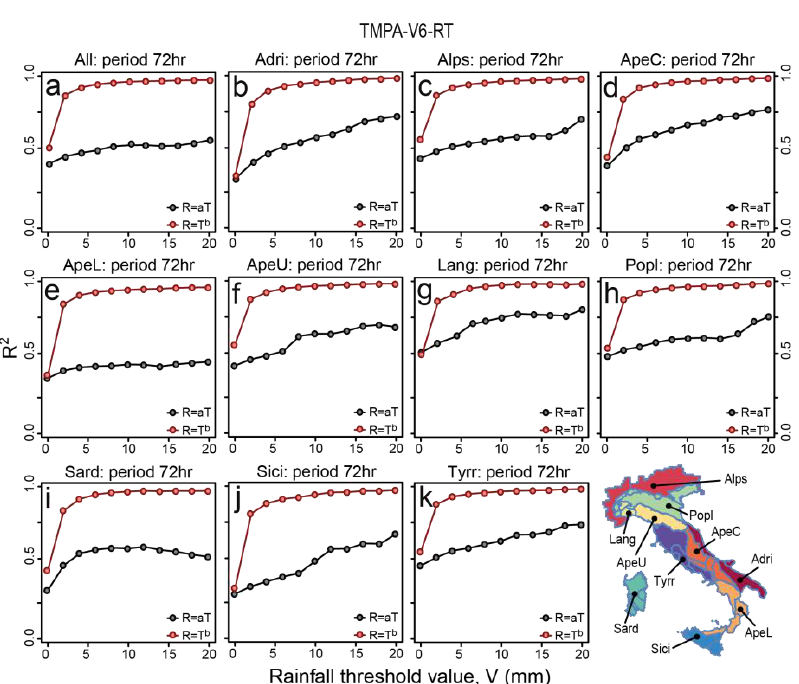
Figure 6. Linear (grey dots) and power-law (red dots) fitting (between TMPA-V6-RT rainfall estimates and VRF ground data) determination coefficients for the 72-h cumulative rainfall filtered using a peak over threshold approach taking values above different thresholds: 0, 2, 4, 6, 8, 10, 12, 14, 16, 18 and 20 mm. The different plots show results for different Italian morphological subdivisions: ( a ) entire Italian territory; ( b ) Adri; ( c ) Alps; ( d ) ApeC; ( e ) ApeL; ( f ) ApeU; ( g ) Lang; ( h ) Popl; ( i ) Sard; ( j ) Sici; ( k ) Tyrr.